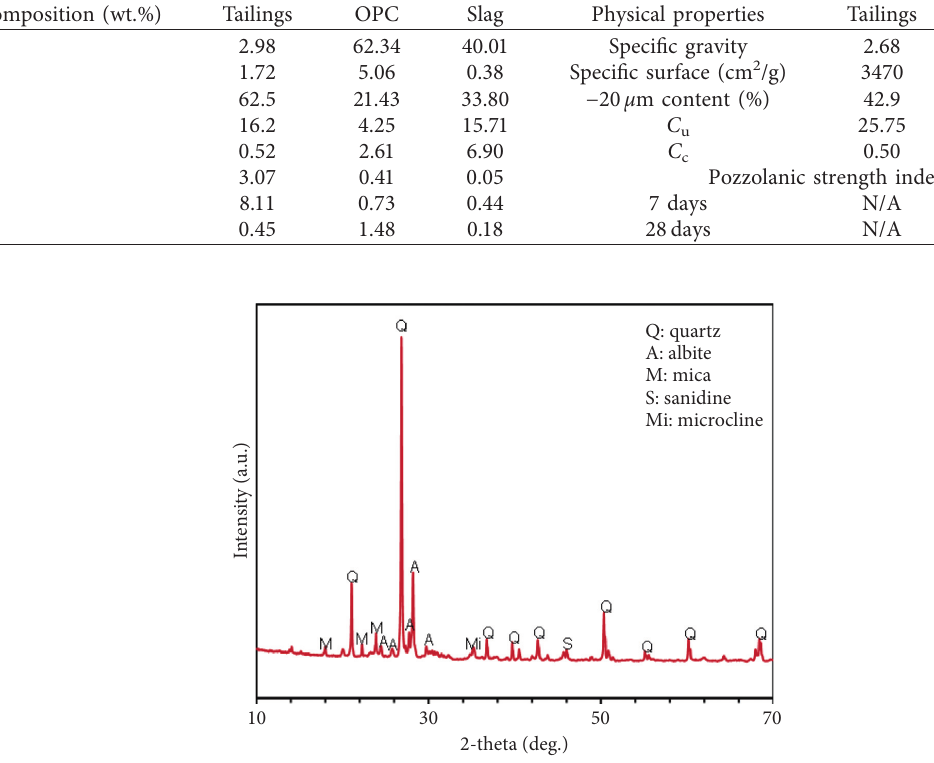
Figure 2: XRD pattern of tailings.